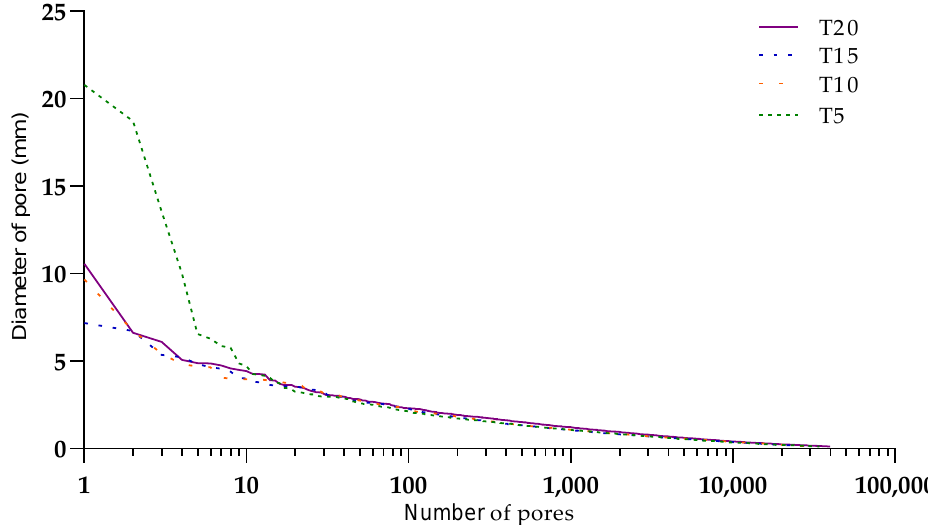
Figure 14. Volumetric pore distributions based on volumetric CT scans, which are described in more detail in Table 5.